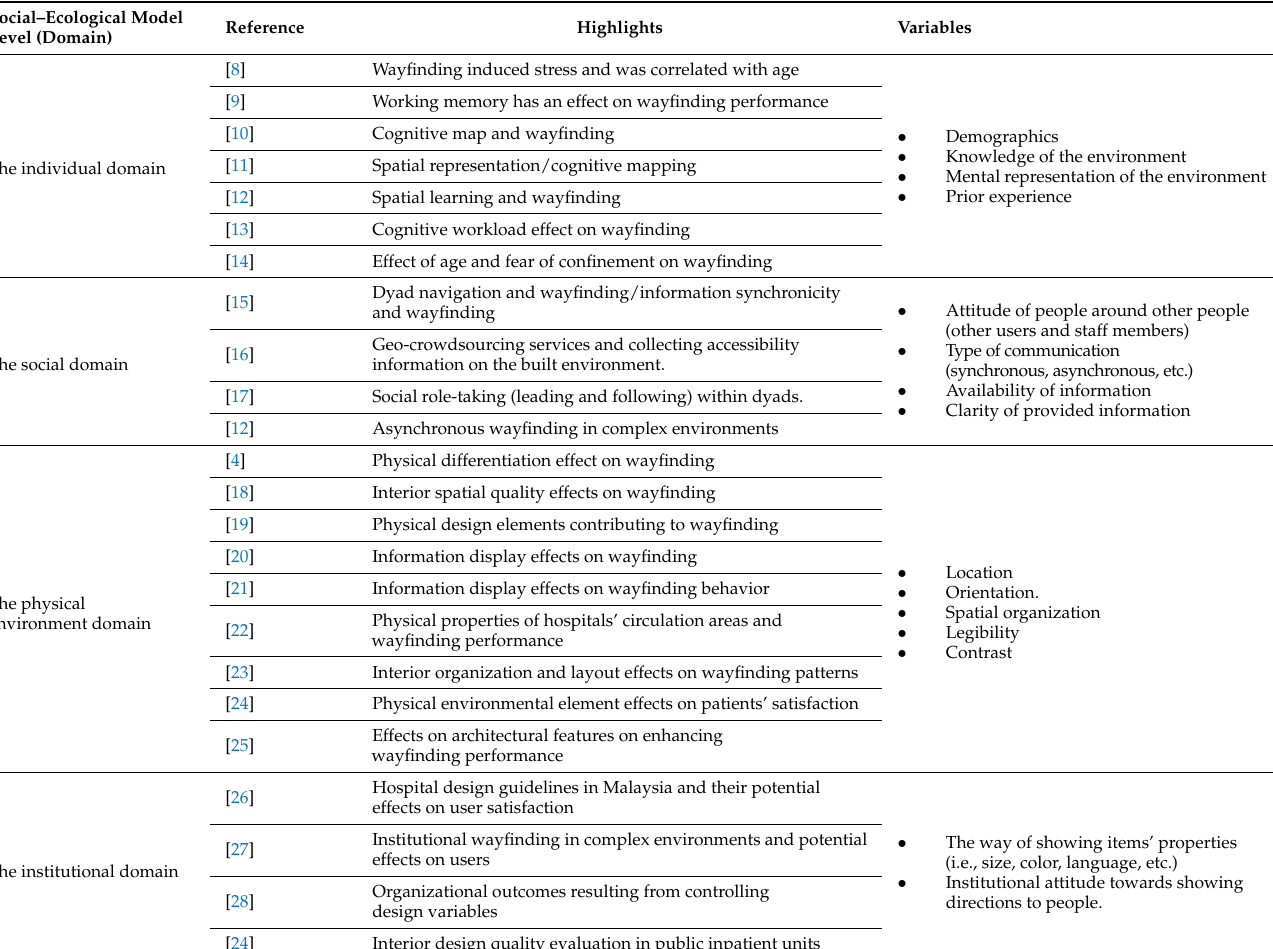
Table 1. The domains and factors identified in some of the recently published research in the field of